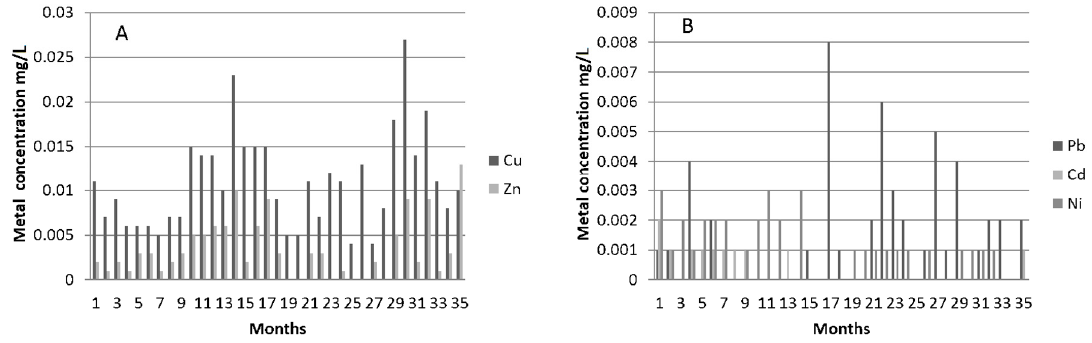
Figure 4. Metal effluent quality ( A ) Cu and Zn ( B ) Pb, Cd, Ni (mg/L).